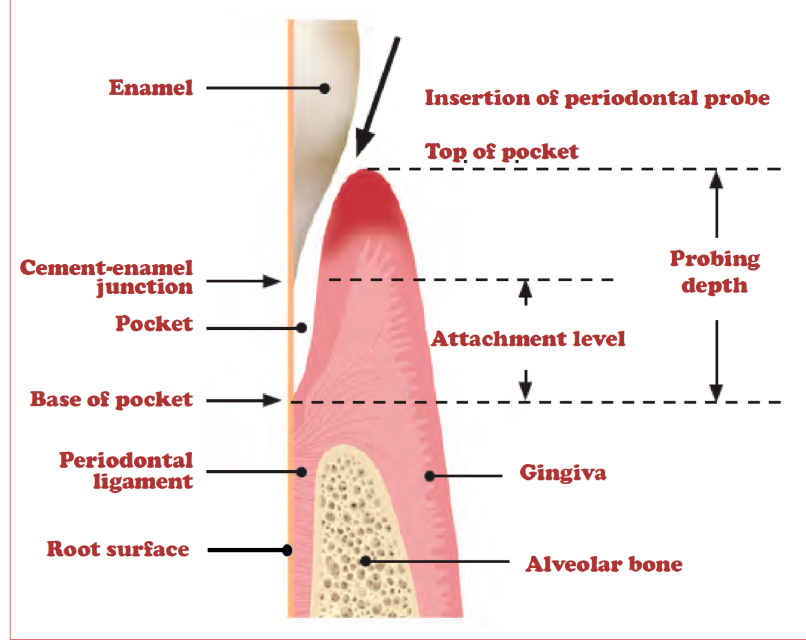
Figure 14. Diagram of a longitudinal section through the periodontal pocket illustrating the gingival recession and the exposure of the tooth root surface.